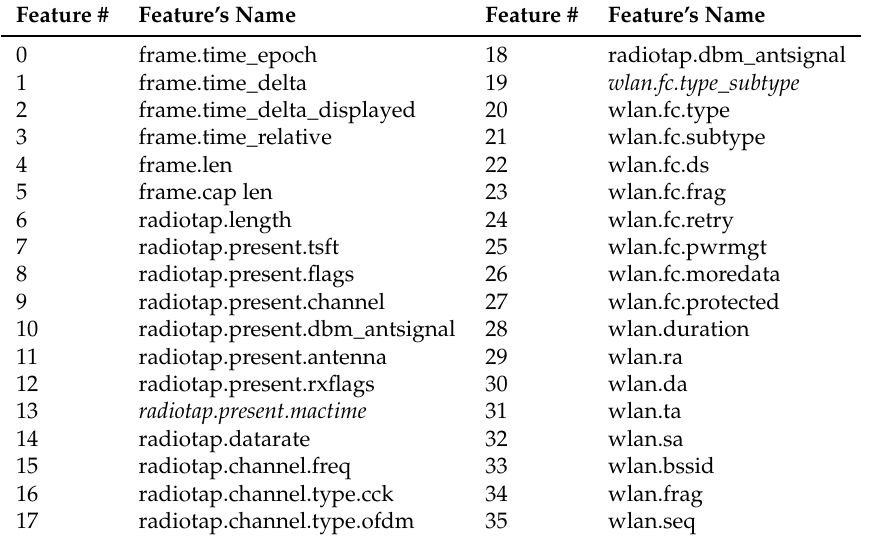
Table 3. Features remained in the AWID dataset after initial data